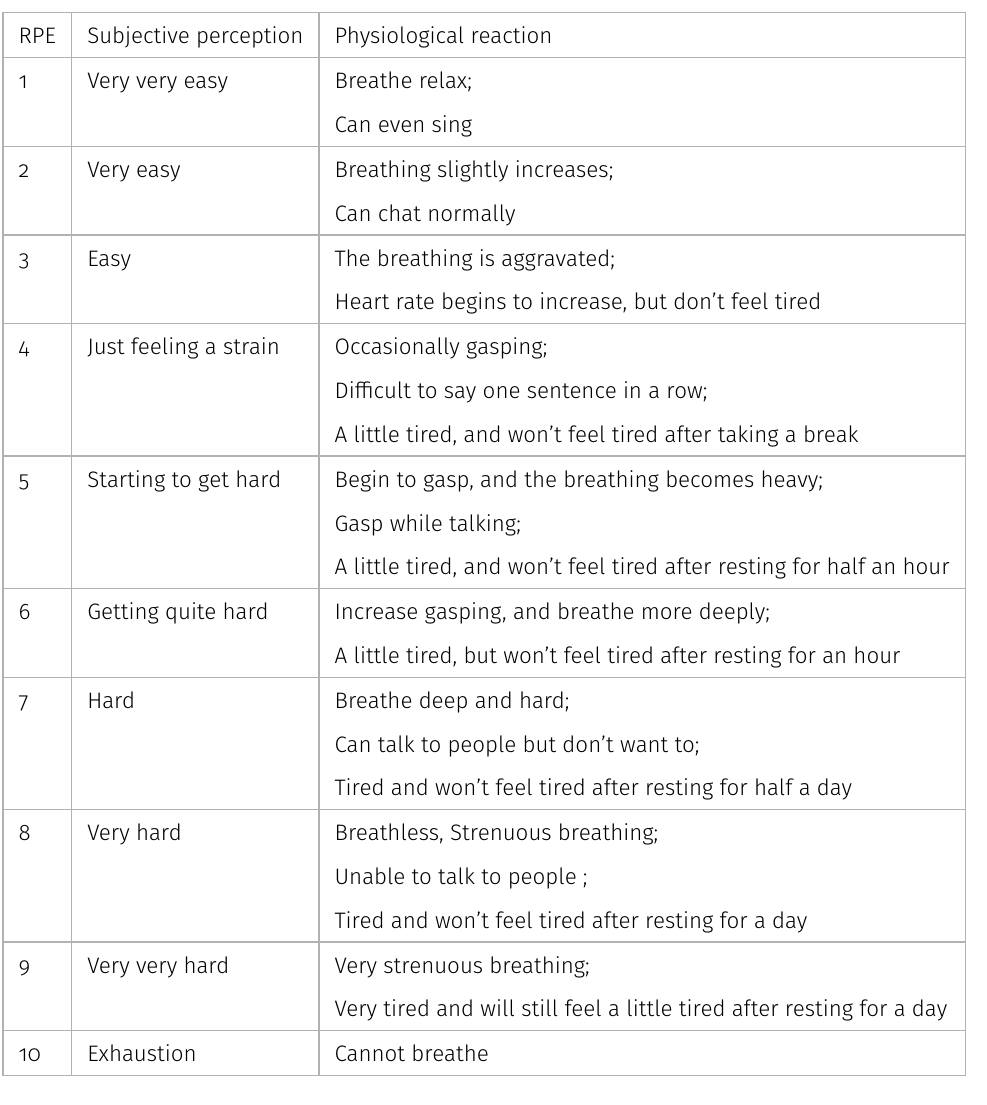
Table II. Improved CR-10